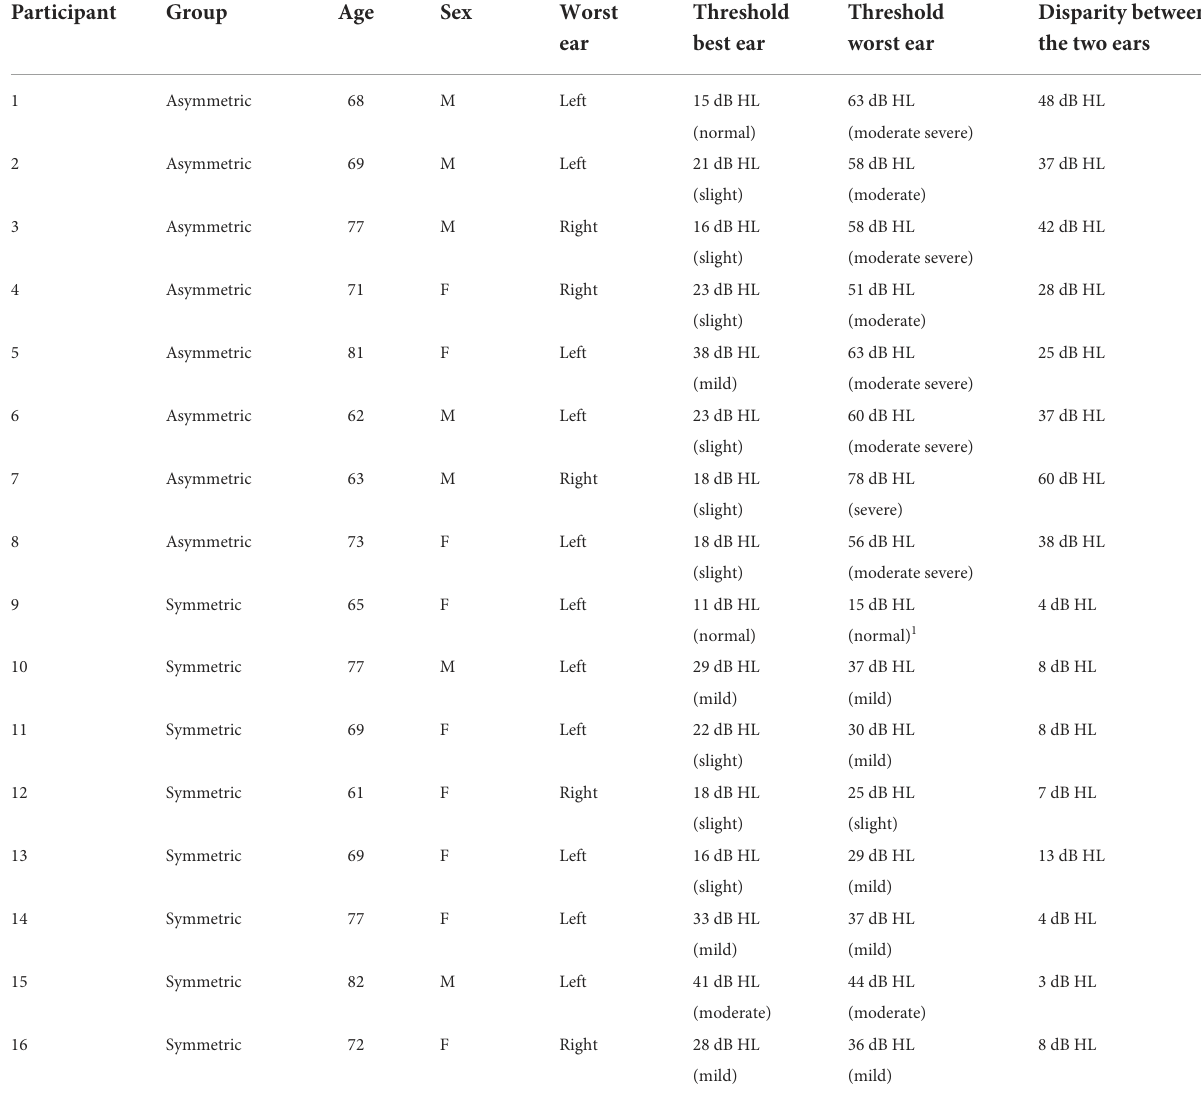
TABLE 1 Personal and audiometric characteristics of